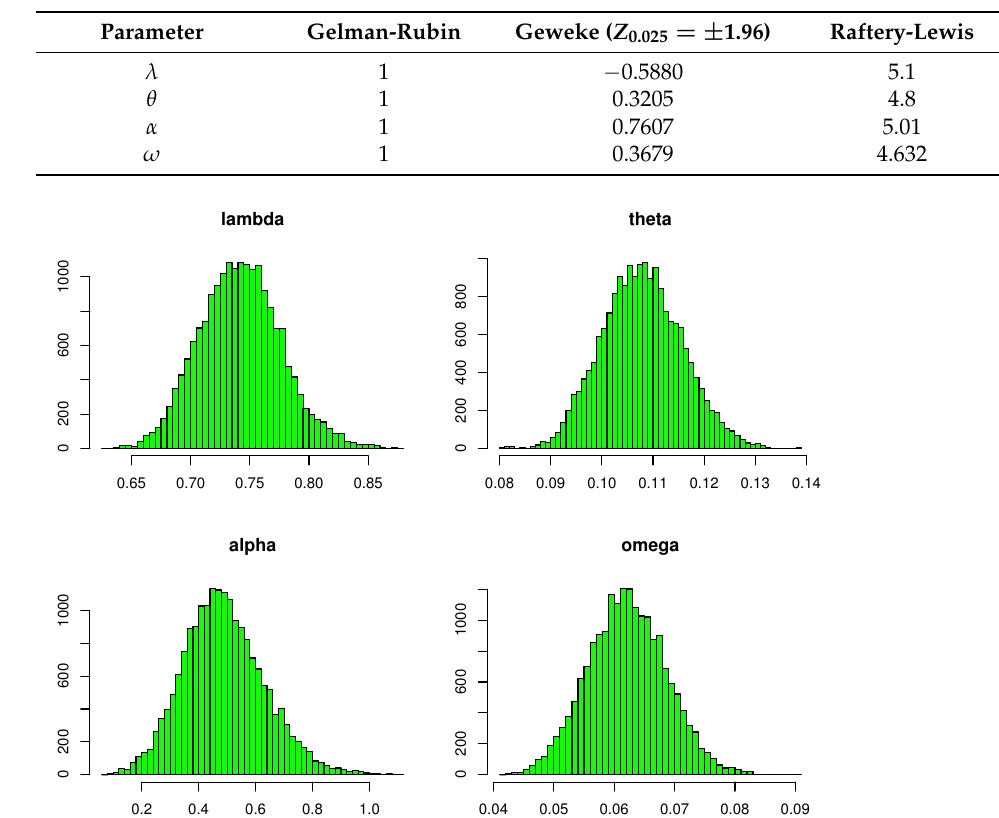
Table 6. Diagnostics using the Gelman-Rubin and Geweke-Raftery-Lewis methods for parameters α , β and λ based on DS1 dataset.